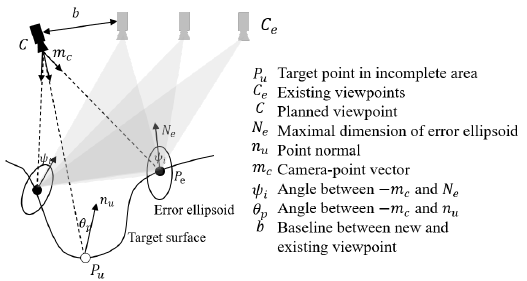
Figure 2. The geometry illustration of viewpoint addition for